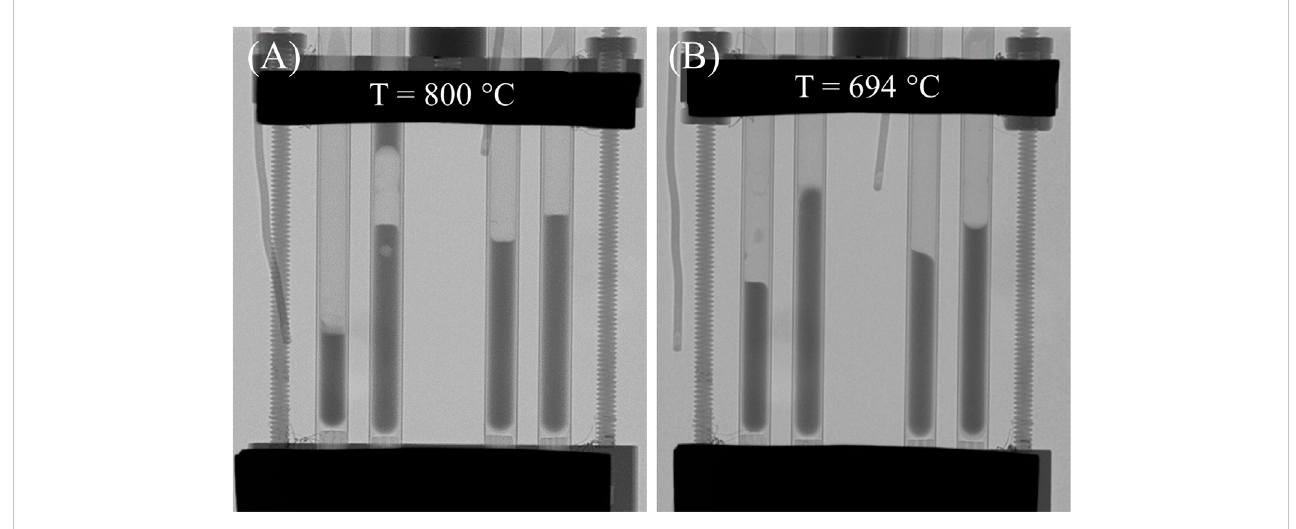
FIGURE 1 Radiographs of molten chloride salts. (A) Above the melting point (800 ° C), entrained bubbles occur in NaCl-KCl. (B) A salt, that is, undergoing its second heating cycle has menisci that indicate wetting and nonwetting for the same sample. This fi gure is modi fi ed from Moon et al. (2022b) (Figure